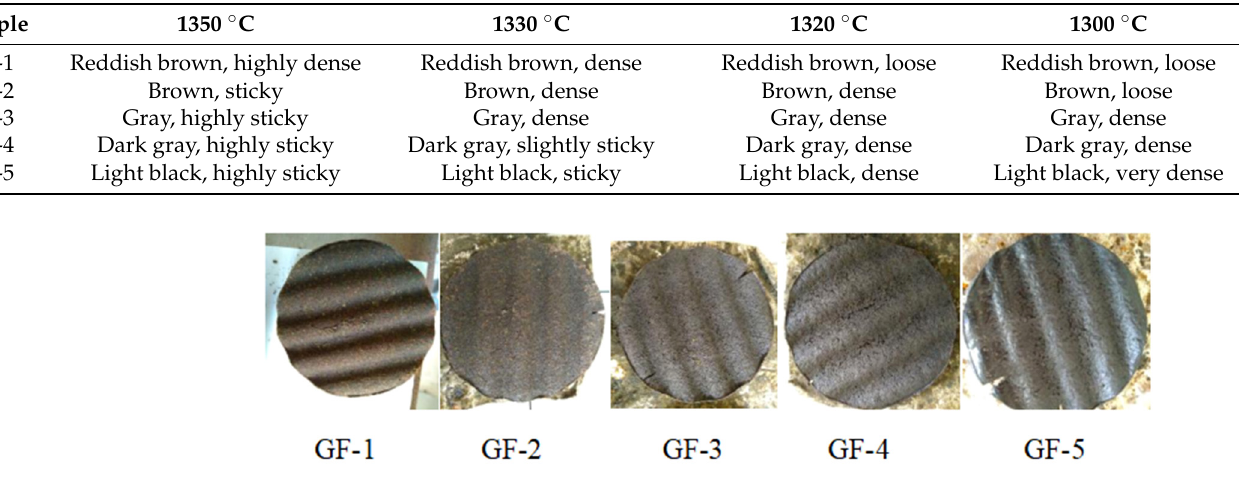
Figure 2. Photos of HBSC clinker appearance sintering at 1330 °C.